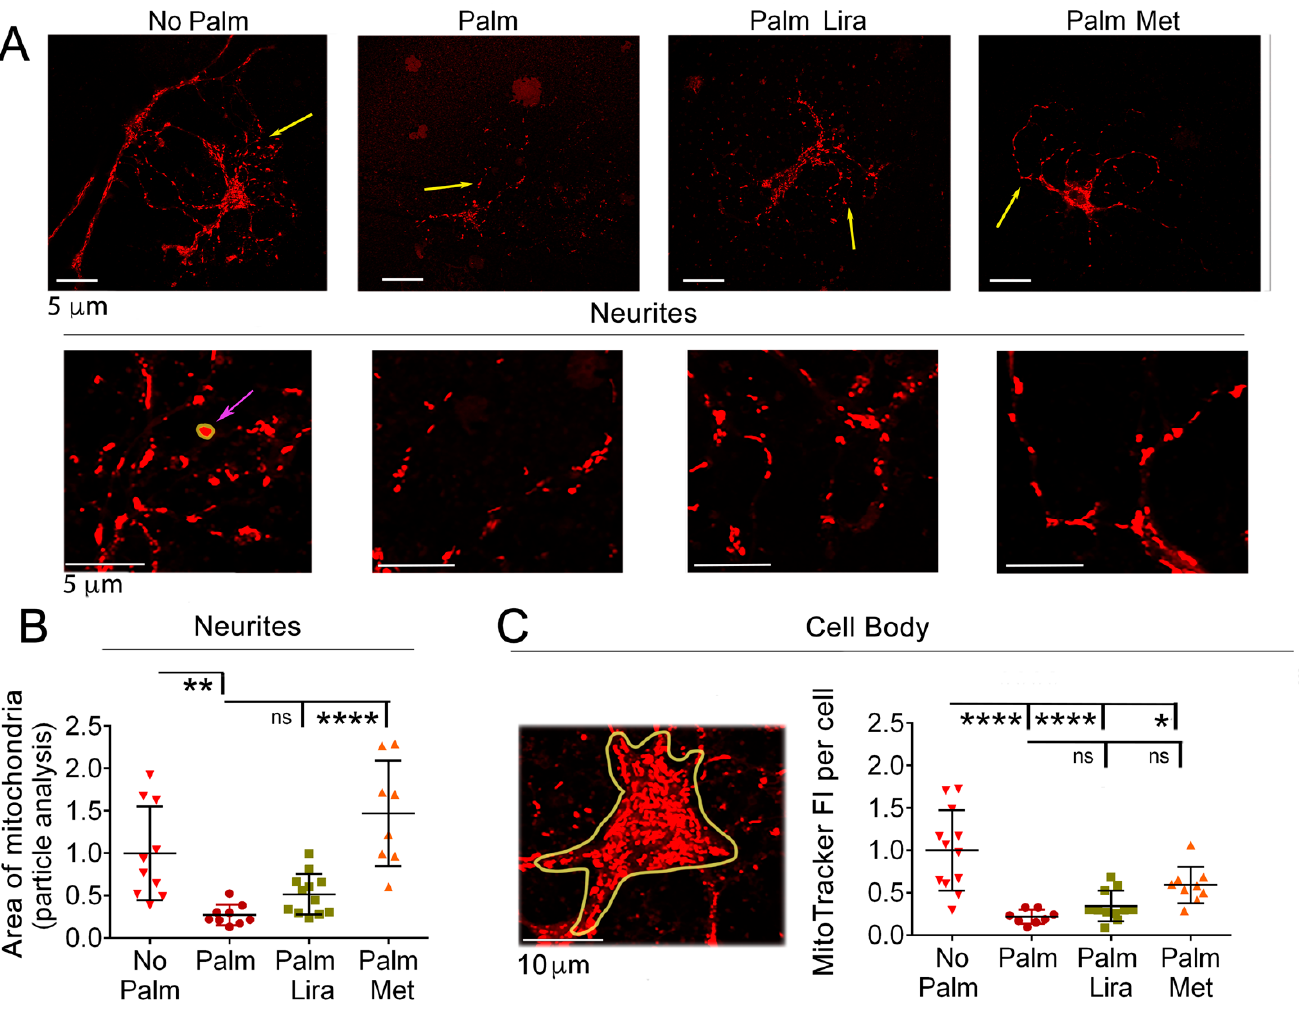
Figure 6. Exposure to palmitate induces mitochondrial fragmentation and depolarization. Metformin and liraglutide do not prevent mitochondrial changes. ( A ) Cells treated as in Figure 4A were incubated for 15 min in the presence of 200 nM Mitotracker Red Red CMXRos, washed, and imaged by live cell microscopy with the 60 × objective of the Olympus SV-1000 in complete medium. Neuronal process indicated by yellow arrows are shown enlarged in the lower panels. ( B ) Areas of mitochondria (yellow line encircles one representative mitochondrial area indicated by magenta arrow) were measured along the entire length of at least two processes per neuron by using the “particle analysis” tool of ImageJ. Each symbol in the graph represents the average mitochondrial area per neuron (n ≥ 8 neuron per group, including those shown in panel ( A ), with ~50–100 mitochondria per neuron) measured in ROIs at neurites (a yellow line encircles one representative ROI). ( C ) Integrated fluorescence intensity per cell of MitoTracker in ROIs that include the cytoplasm (a representative ROI is the area encircled by yellow line using ImageJ software). * p < 0.05; ** p < 0.01; **** p < 0.0001, ns, not significant.